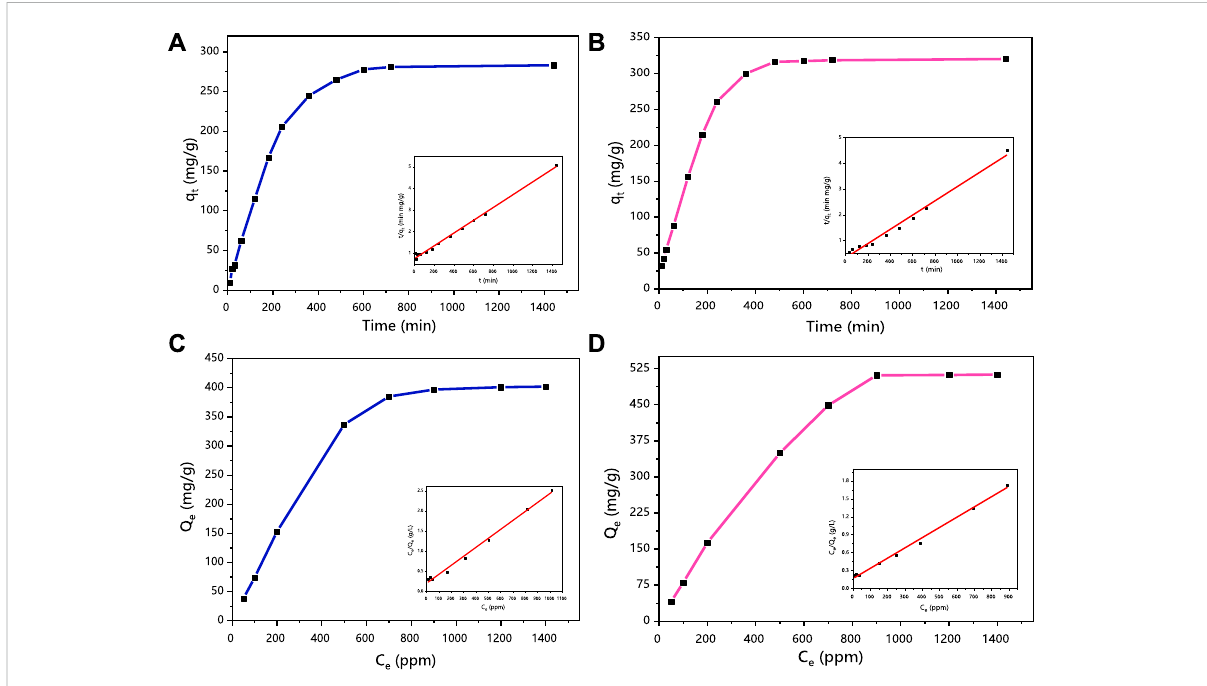
FIGURE 2 (A) Adsorption kinetics curves of HCSS for Hg (II) removal. (B) Adsorption kinetics curves for Cr(VI) removal. Inset fi gure: pseudo-second-order fi tting.Conditions:C0 =400 ppm;sample volume:10 ml;dosage: 1.0 g/L; pH6.5; and temperature:25 ° C. (C) Isothermsof HCSSon Hg(II)removal. (D) Isotherms of HCSS on Cr (VI) removal. Inset fi gure: Langmuir model fi tting. Conditions: sample volume: 10 ml; dosage: 1.0 g/L; reaction time: 24 h; pH 6.5; and temperature: 25 ° C.